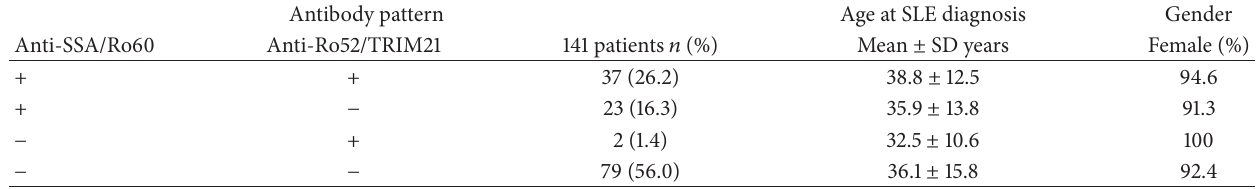
Table 1: Demographic characteristics of SLE patients on the basis of their anti-SSA/Ro60 and anti-Ro52/TRIM21 pattern.